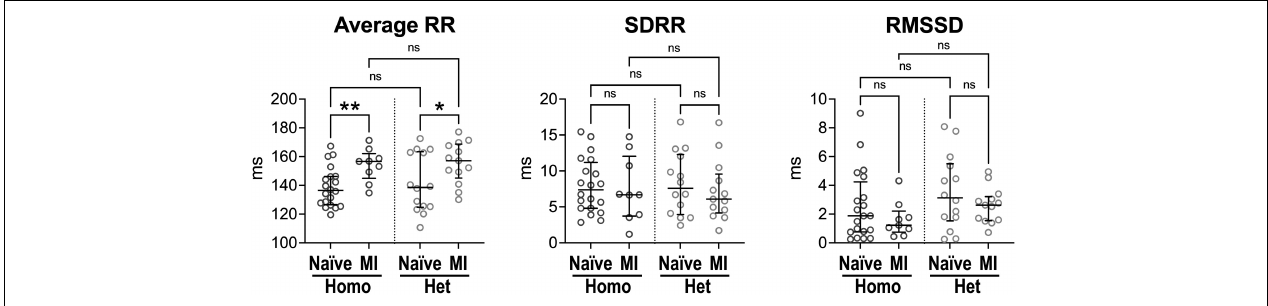
FIGURE 4 | Intrinsic beating rate dynamics in normal and infarcted Homo and Het hearts. Quantitative data for average RR interval duration and time-domain parameters of HRV in naïve and infarcted hearts from Homo ( n = 20, n = 9) and Het ( n = 14, n = 13) male and female mice. Data are shown as scattered plots with median and interquartile ranges. ns, not significant, *P < 0.05, **P < 0.01, using unpaired t -test or Mann-Whitney